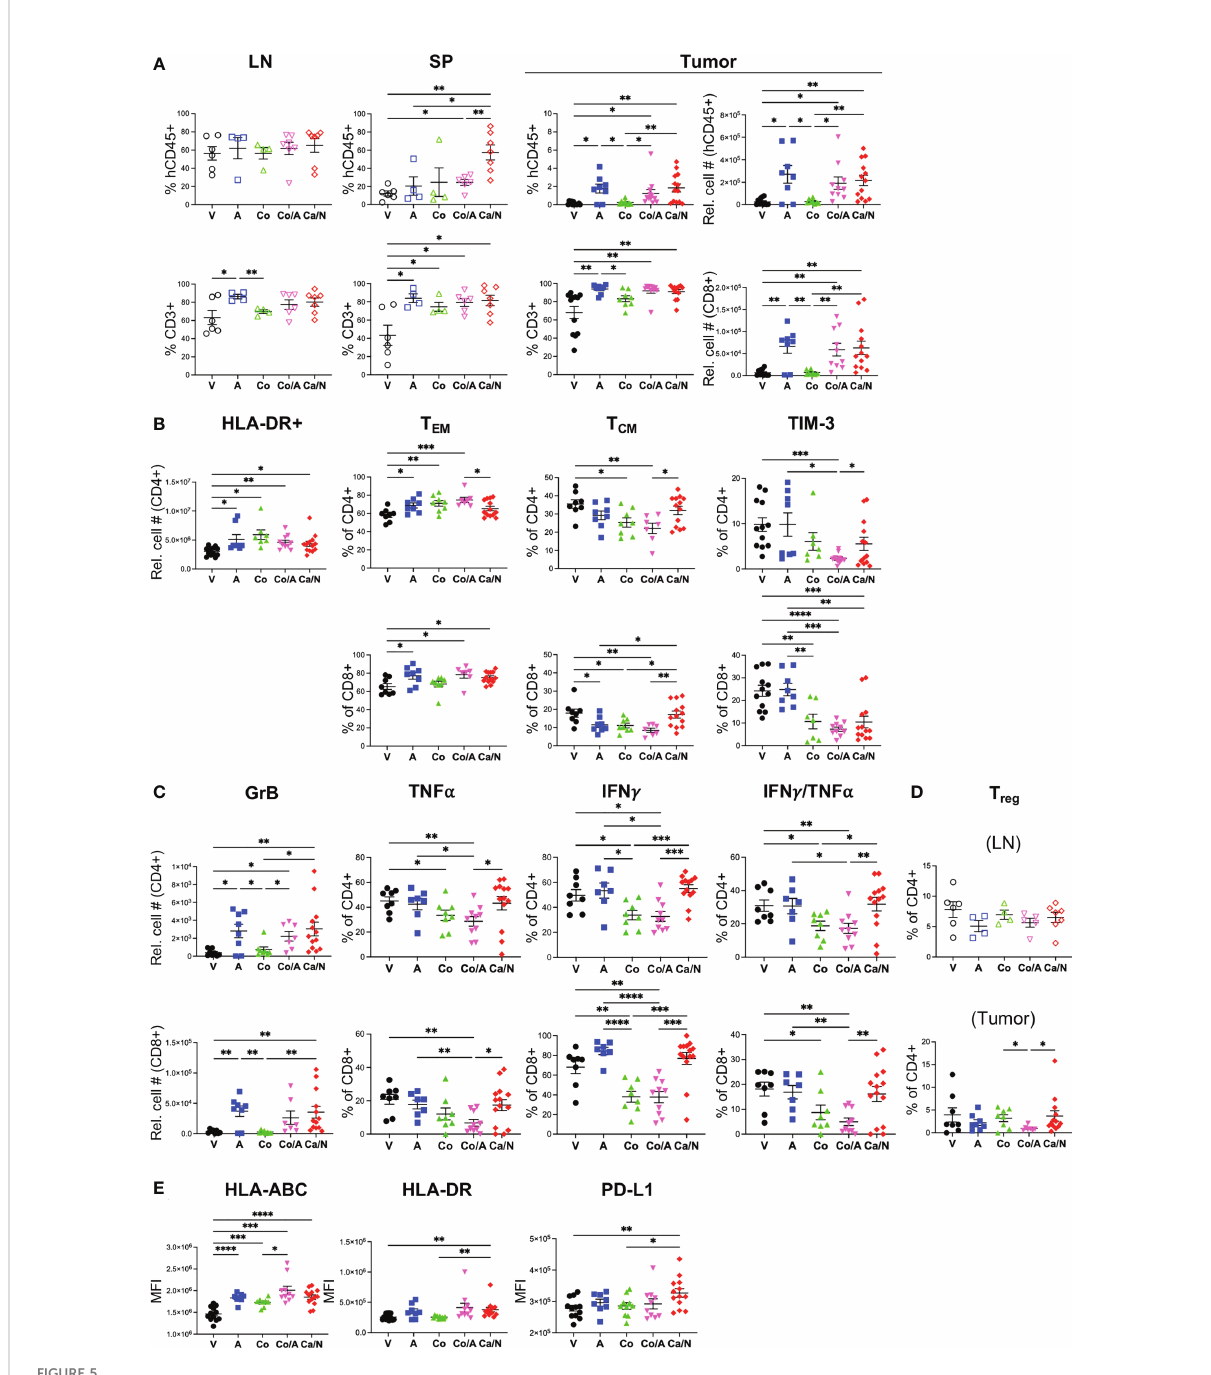
FIGURE 5 Increased central memory and cytotoxic T cell frequencies in CRC PDX MSS tumors explanted from HIS-BRGS mice treated with cabozantinib/ nivolumab (Ca/N) combination relative to those treated with cobimetinib/atezolizumab (Co/A). Phenotypes of human immune system in LN, spleen (SP) and TILs (CU-CRC307P) from HIS-BRGS mice treated with nothing (V), atezolizumab (A) , cobimetinib (Co), combination Co/A or Ca/ N: frequencies and/or numbers of (A) hCD45+ (Top row) and human T cells (CD3+, bottom row), (B) T cell populations (CD4+ top, CD8+ bottom) in the CRC307P TILS: activated HLA-DR+ (left panel), effector memory (CCR7-, CD45RO+, left middle panel), central memory (CCR7+, CD45RO+, right middle panel) and exhausted TIM-3+ (right panel); (C) Cytotoxic T cells (CD4+ top, CD8+ bottom) expressing Granzyme B (left panels) ex vivo or TNF a (left middle panels), IFN g (right middle panels) or both TNF a IFN g (right panels) following overnight cell stim and 4 hour Golgi block; (D) T regs (FoxP3+, CD25+) in LN (upper) and tumor (bottom); and (E) expression (MFI) of MHC class I (HLA-ABC, left), class II (HLA-DR, middle) and PD-L1 (right) on CRC307P EpCAM+ tumor cells. P-values indicate ANOVA multiple comparisons with Welch ’ s correction: *p < 0.05, **p < 0.01, ***p < 0.001, ****p < 0.0001 or as indicated by